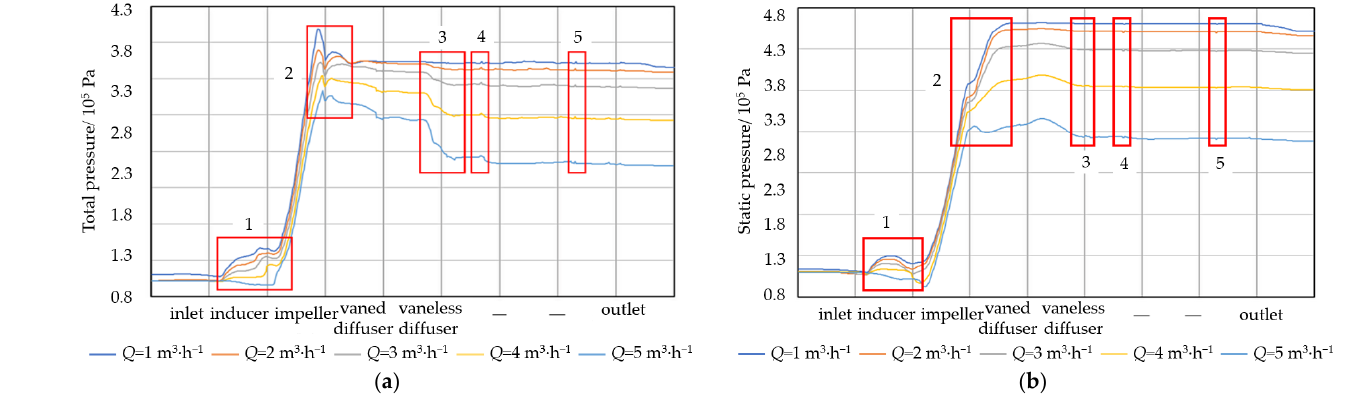
Figure 6. Pressure distribution of centrifugal pump fluid along streamline. ( a ) Total pressure distribution of centrifugal pump fluid along streamline; ( b ) static pressure distribution of centrifugal pump fluid along streamline.